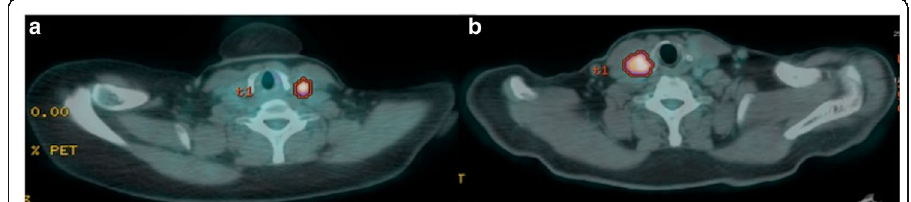
Fig. 2 Examples of pattern of [ 18 F]FDG uptake at PET/CT images of 2 thyroid incidentalomas identified by the region of interest (red circle). Intense [ 18 F]FDG uptake was observed in a benign nodule (TIR3 at cytology) of the left thyroid lobe ( a ) and in a differentiated thyroid cancer (TIR5 at cytology) of the right thyroid lobe ( b )